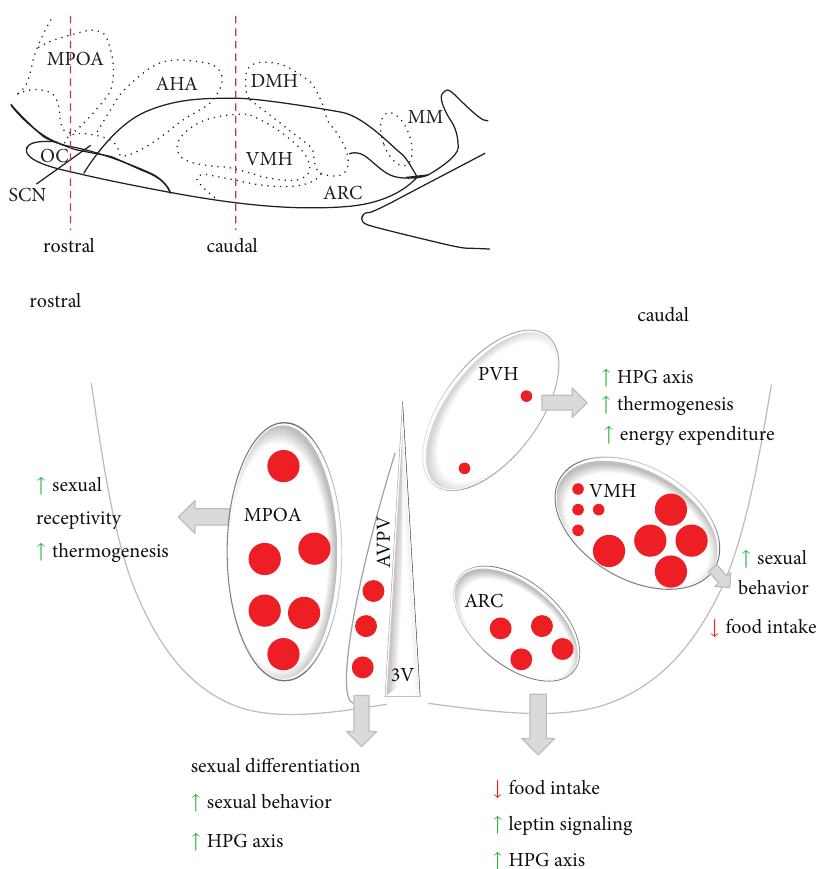
Figure 2: Distribution of ER 𝛼 in the hypothalamus and their physiological effects. Schematic coronal section showing locations of major nuclei in the rostral (left) and caudal (right) hypothalamus containing ER 𝛼 -expressing cells, the relative quantities of ER 𝛼 in these nuclei (large red dots indicate abundant distribution and small red dots indicate scarce distribution), and their physiology effects in reproduction and energy